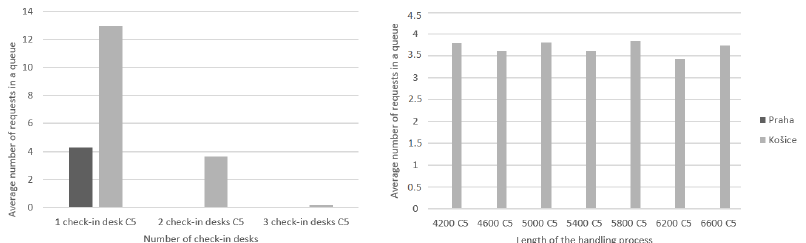
Figure 14. The effect of changing the number of check ‐ in desks and the length of handling time on C5.